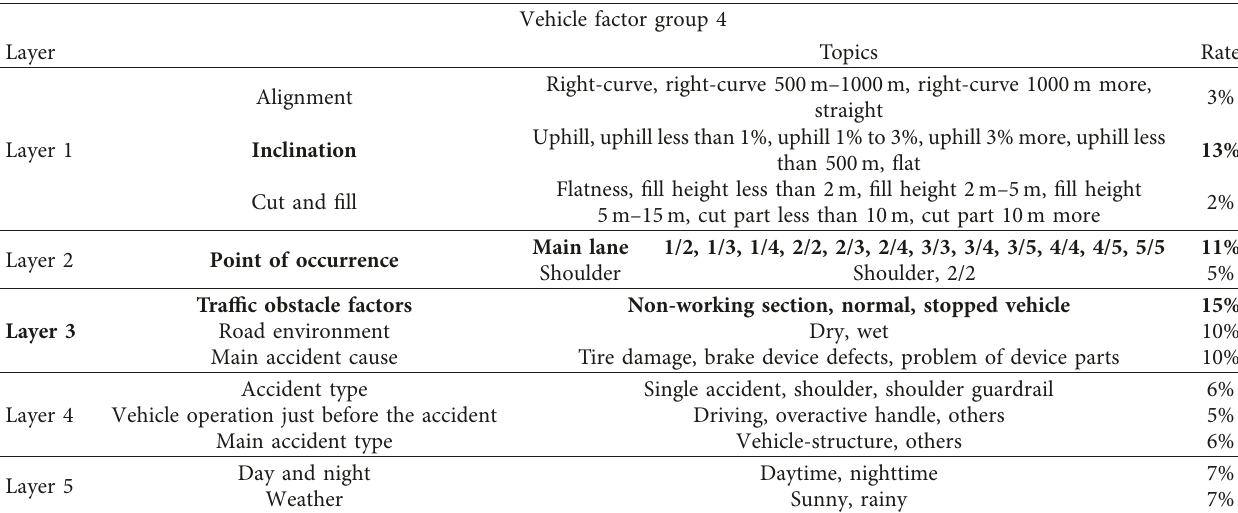
Table 8: Vehicle factor topic modeling group 4.